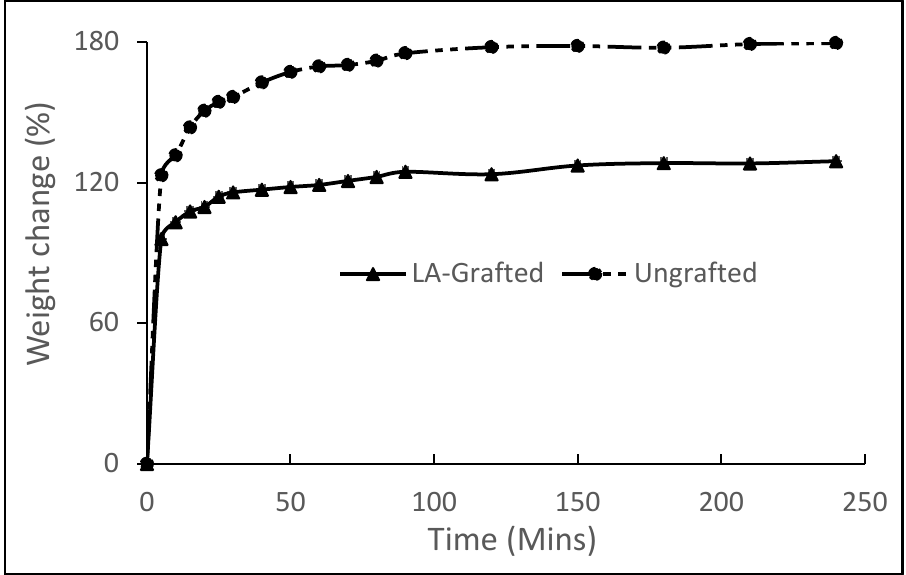
Figure 5. Water absorption properties of CNF films.